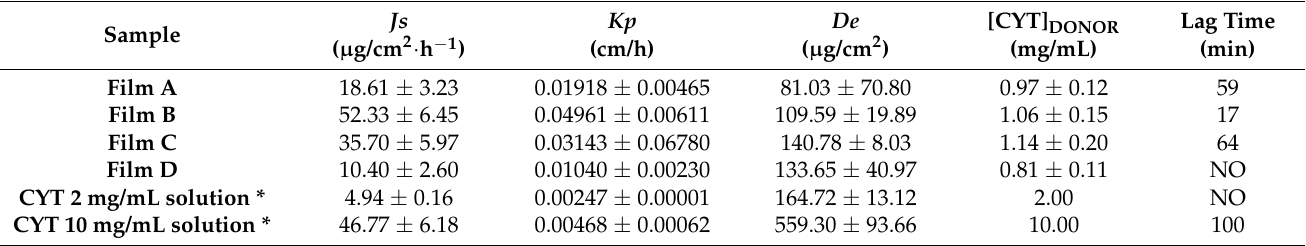
Table 8. Extrapolated CYT biopharmaceutical parameters ( Js , Kp , t lag , and De ± SE ) and experi- mental concentration into the donor chamber when evaluating the buccal films as CYT solutions as a